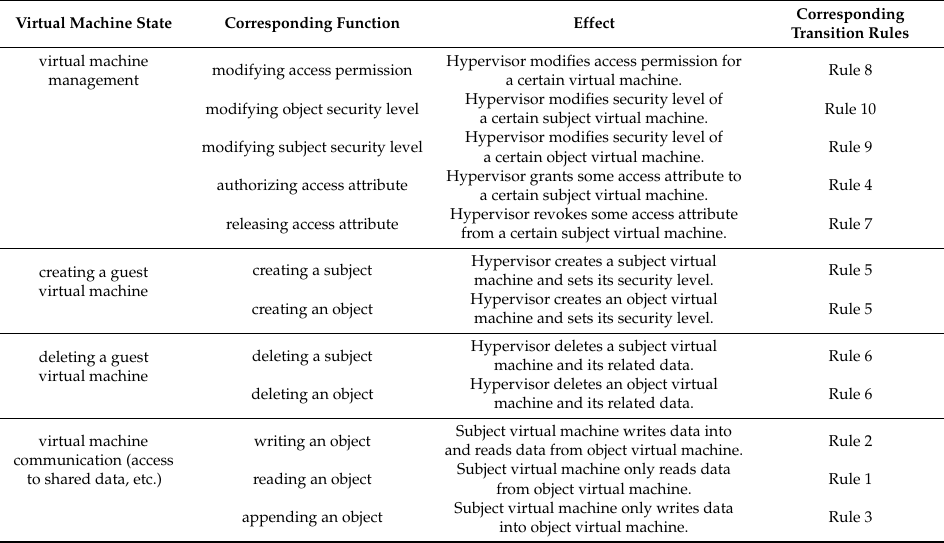
Table 1. State transition